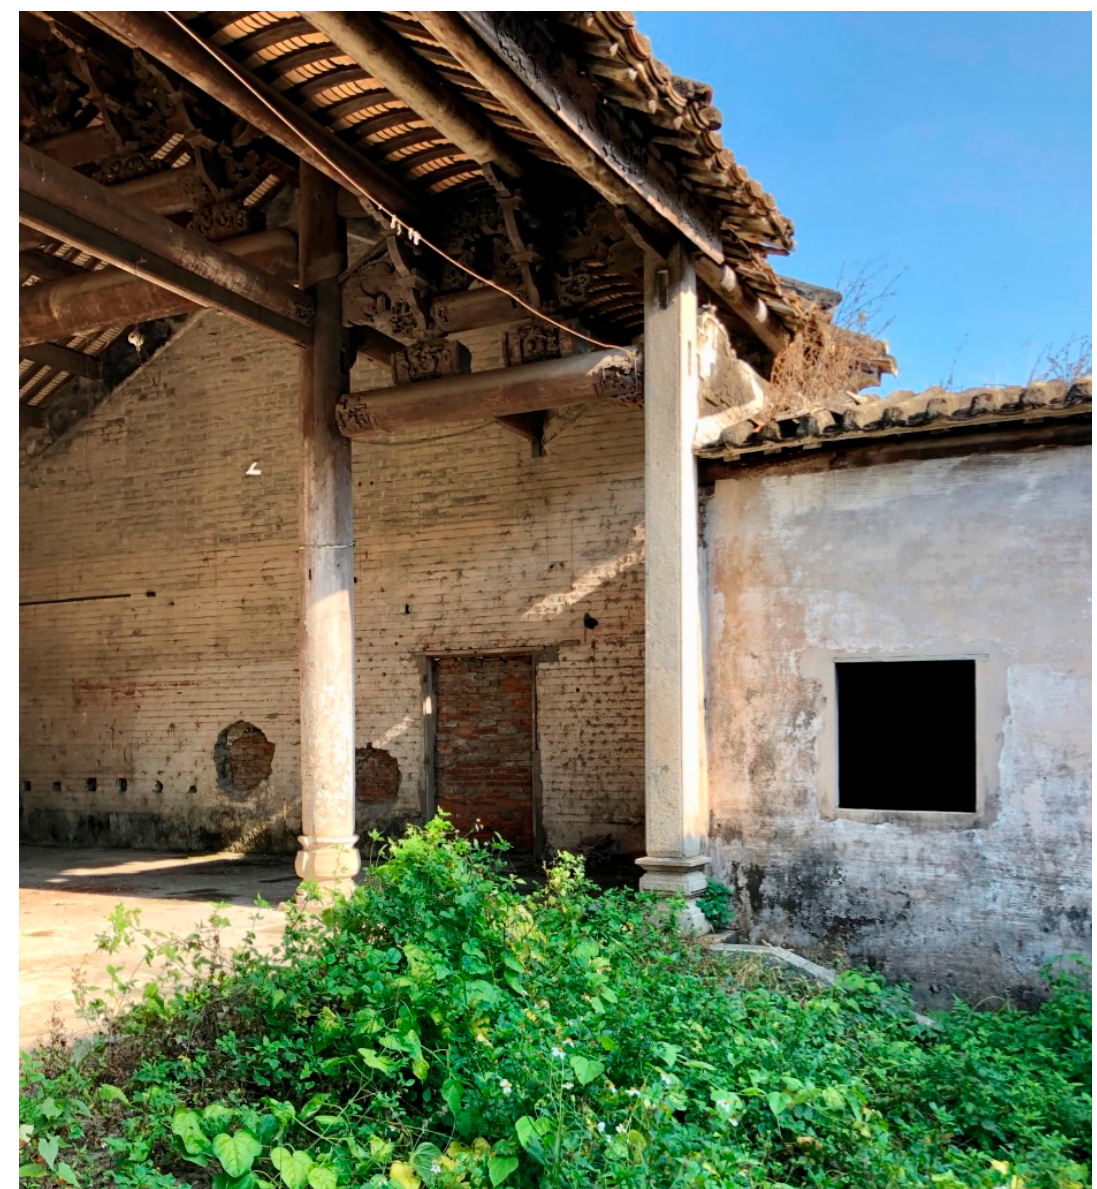
Figure 3. A deserted temple building in Wushi village (Zhongshan Prefecture, southeast China), used as a factory during the Mao era, is subject to a fund-raising campaign for its restoration. Photo by Denis Byrne,